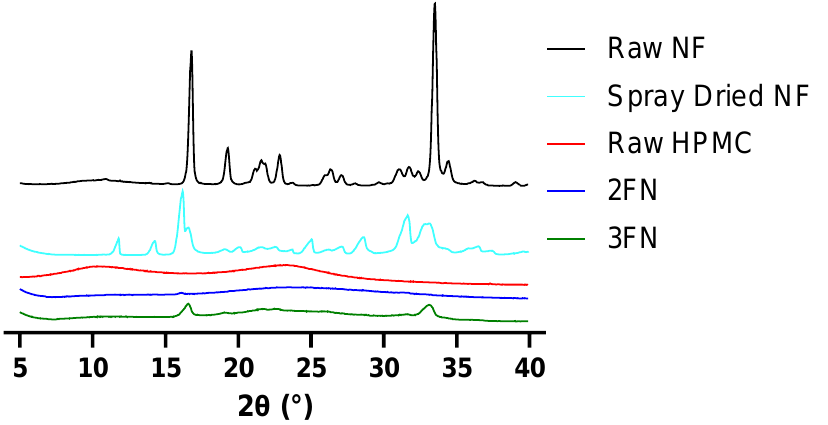
Figure 2. X-ray diffraction patterns produced by 2FN and 3FN formulations along with raw NF, spray-dried NF (drug only) and raw HPMC.